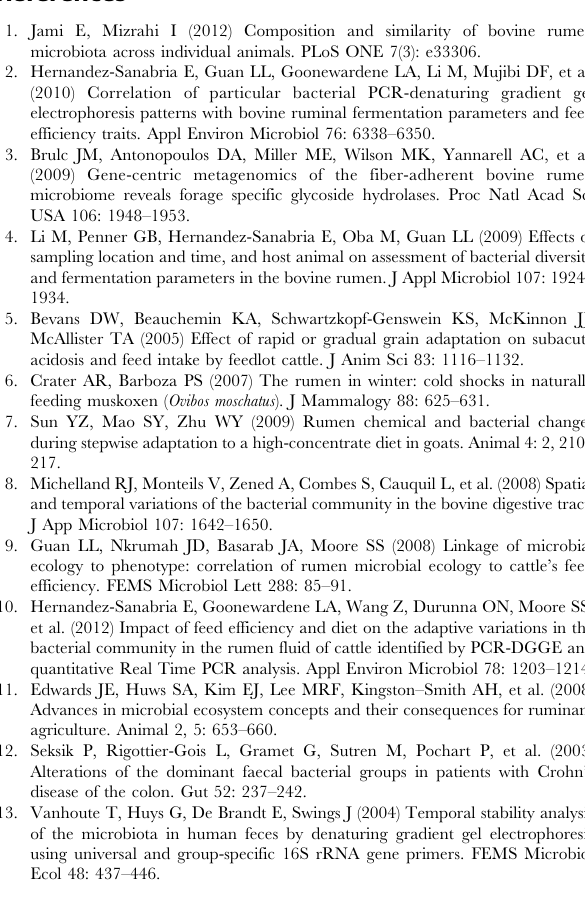
Table S2 Correlation (r) of fermentation metabolites in the rumen of ANG,CHA, and HYB steers under HE diet with phenotypic indicators of metabolic differences (RFI, DMI and FCR) and bacterial and methanogen